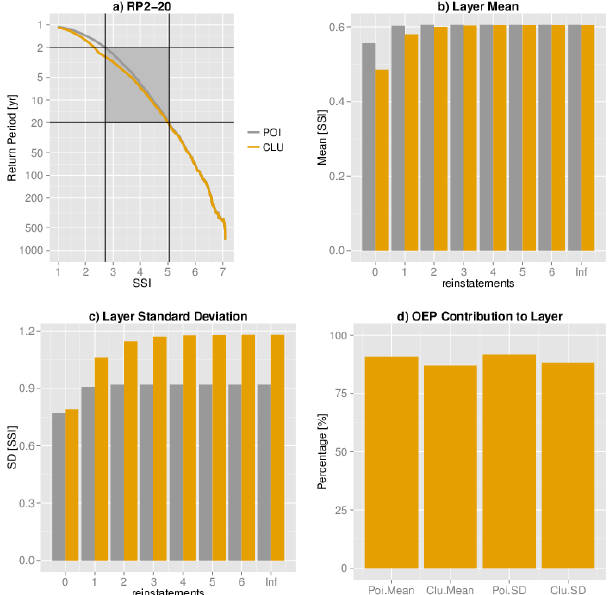
Figure 5. As in Fig. 4 except that the attachment and exhaustion point are defined at 20- and 50-year return periods